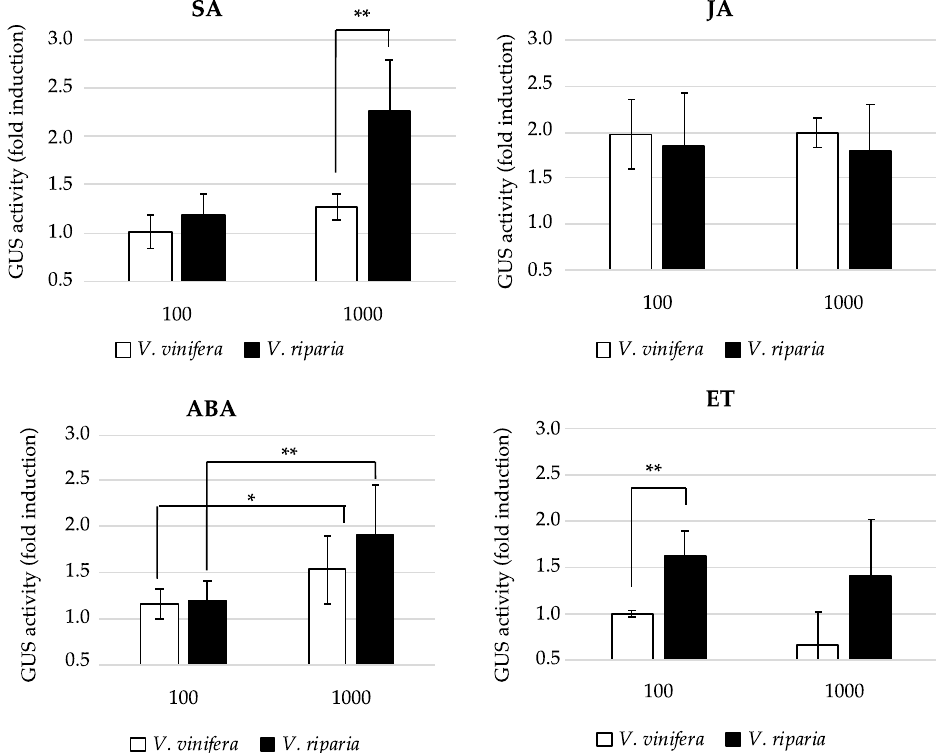
Figure 2. ATL156 promoters respond differently to hormone treatments. GUS activity induction measured in Arabidopsis thaliana leaves expressing the gusA gene under the control of the Vitis vinifera or Vitis riparia ATL156 promoters, following treatment with salicylic acid (SA), jasmonic acid (JA), abscisic acid (ABA) or the ethylene donor ethephon (ET). Values are means of three biological replicates ± SE and statistically significant differences calculated with Student’s t -test are indicated as * = p ≤ 0.05; **, p ≤ 0.01.